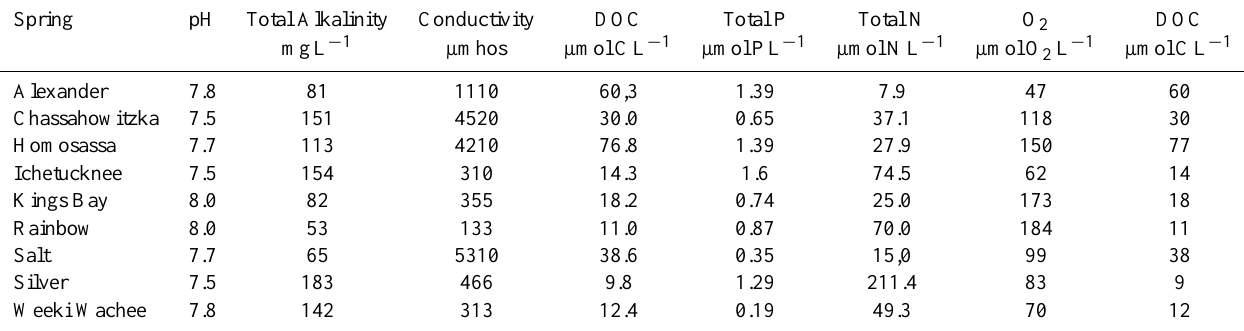
Table 1. pH, alkalinity, conductivity, DOC concentration, total N and total P concentrations and dissolved oxygen, of the water upwelling at the boils of the Florida springs studied. Water chemistry for Ichetucknee Spring was taken from Scott et al. (2002). Spring pH Total Alkalinity